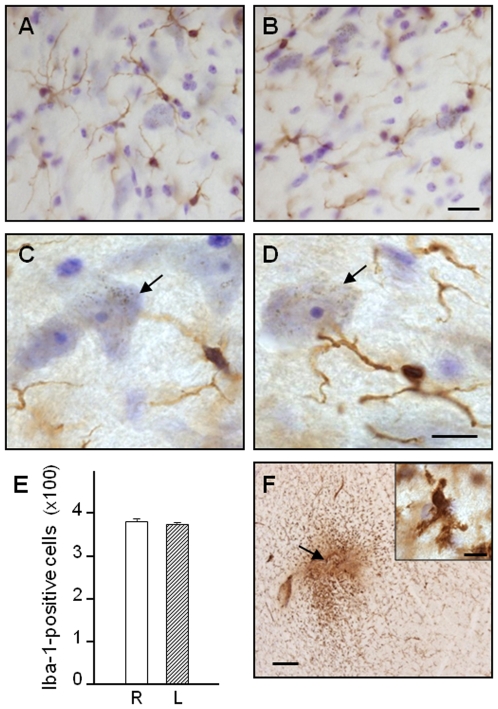
Lack of microglial activation following siRNA infusion.α-Synuclein siRNA was unilaterally infused through a cannula positioned approximately 1 mm dorsal to the substantia nigra. Representative midbrain sections were immunostained for microglial cells using an antibody against ionizing calcium-binding adaptor molecule 1 (Iba-1, brown) and counterstained with cresyl violet (purple). Images are from the right (untreated, A and C) and left (siRNA-infused, B and D) substantia nigra. At higher magnification (C and D), Iba-1-positive cells with morphological features of resting microglia are shown close to dopaminergic neurons containing neuromelanin (black granules). The arrows indicate one of these neurons in each panel. Scale bars = 20 µm (A and B) and 10 µm (C and D). (E) The number of Iba-1-immunoreactive cells was counted in the right (R) and left (L) substantia nigra. Data are shown as mean ± SEM. (F) A representative section from the left midbrain shows Iba-1 immunoreactivity close to the tip of the infusion cannula (arrow) but not within the nearby parenchyma. This robust immunoreactivity was observed within cells with morphological characteristics of activated microglia (inset). Scale bars = 250 µm (panel F) and 10 µm (inset).